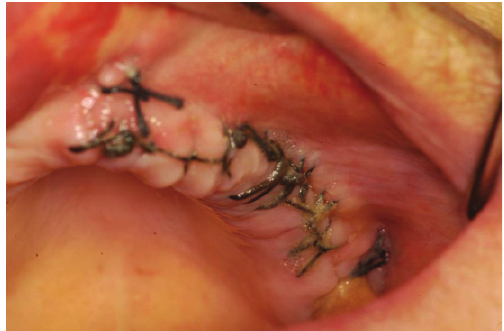
Figure 6: Clinical image of the treated site 1 week after surgery with maintenance of